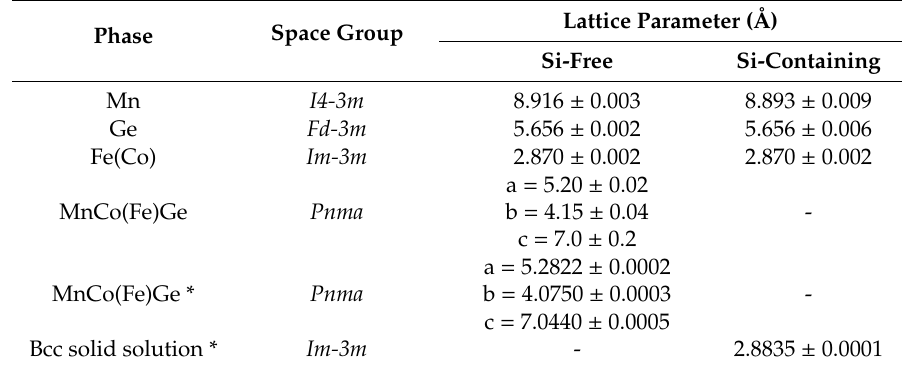
Table 2. Average lattice parameters of the crystalline phases detected by XRD. Changes in this parameter with the milling time is of the order of the error bar.